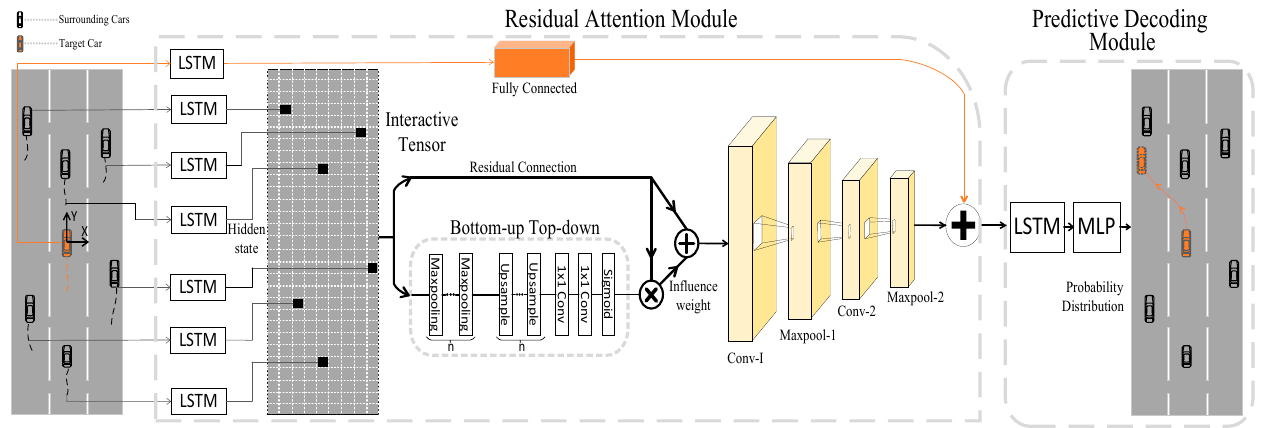
Figure 1. Trajectory prediction model based on residual